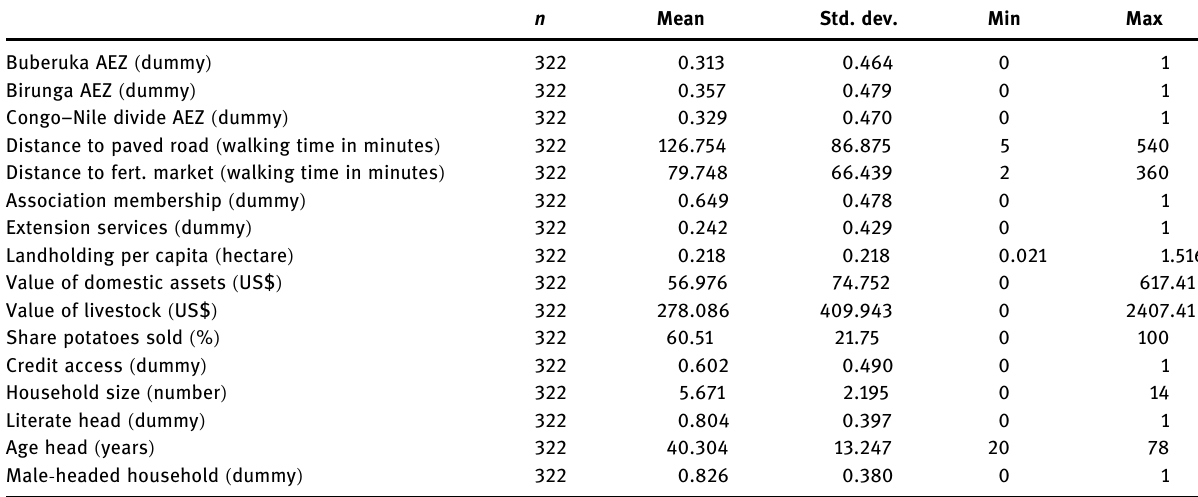
Table 5: Summary statistics of variables hypothesized to a ff ect fertilizer